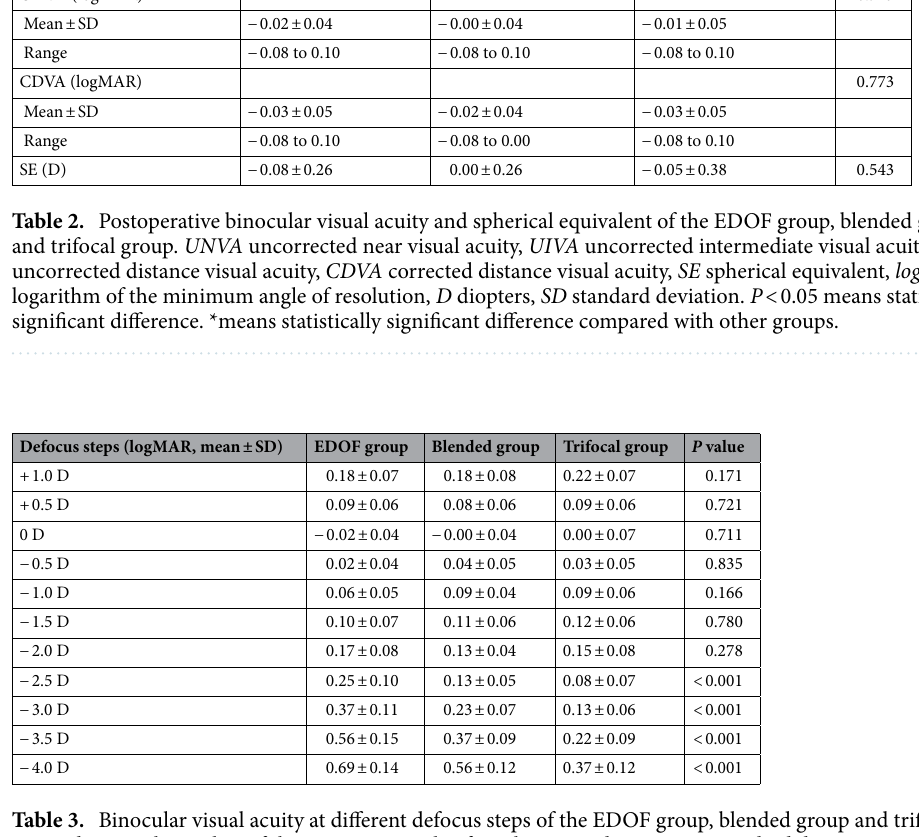
Table 3. Binocular visual acuity at different defocus steps of the EDOF group, blended group and trifocal group. logMAR logarithm of the minimum angle of resolution, D diopters, SD standard deviation. P < 0.05 means statistically significant difference between the three